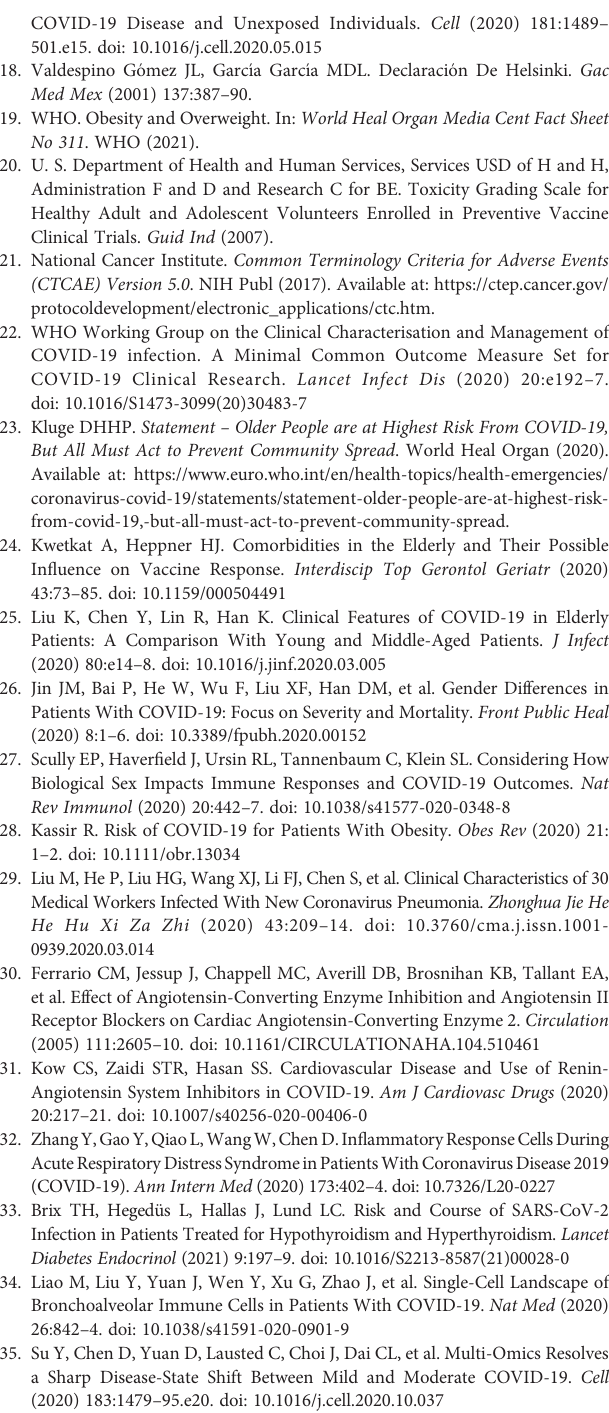
Supplementary Figure 4 | Neutralizing antibody titers of 15 breakthrough cases as compared to 18 vaccinated subjects with no evidence of symptoms associated with COVID-19. Serum samples of individuals were evaluated before vaccine administration (pre-immune), two and four weeks after the second dose. Neutralizing antibodies titers were determined by using (A) a surrogate virus neutralizing test and (B) a conventional virus neutralizing test. The numbers above the spots indicate the geometric mean titer (GMT) and error bars show the 95% CI of the